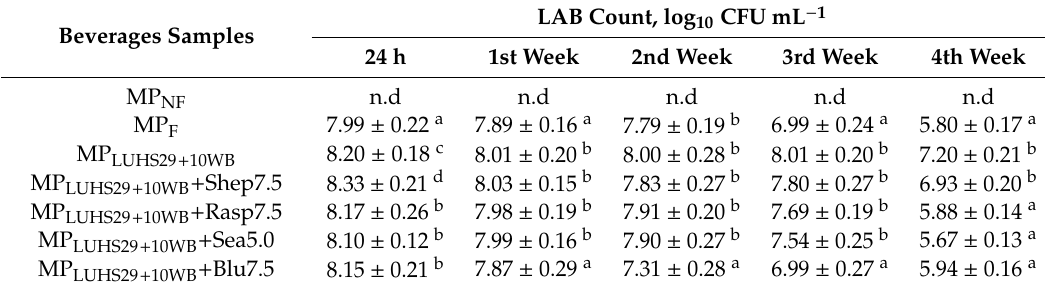
Table 9. Viable lactic acid bacteria (LAB) count in prepared beverages during the four weeks of storage storage at + 4 ◦ C